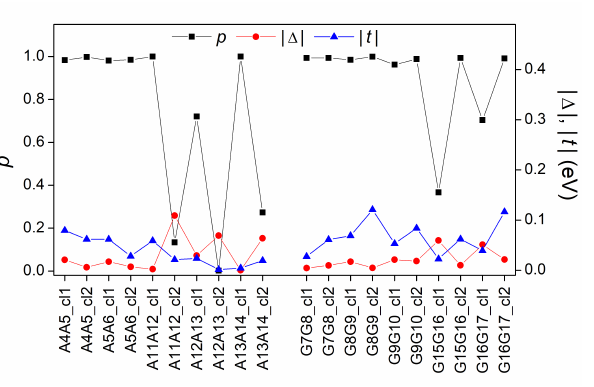
Figure 10. The parameters | ∆ | and | t | , as well as the maximum transfer percentage p for all the dimers of the MD